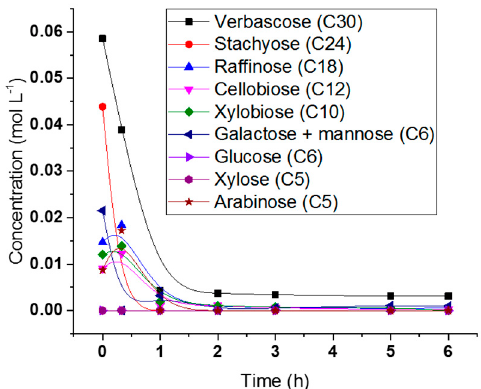
Figure 7. The evolution of oligomers and sugars during the hydrogenolysis of hemicellulose over ReO x -Rh/ZrO 2 at 200 °C under 80 bar H 2 .